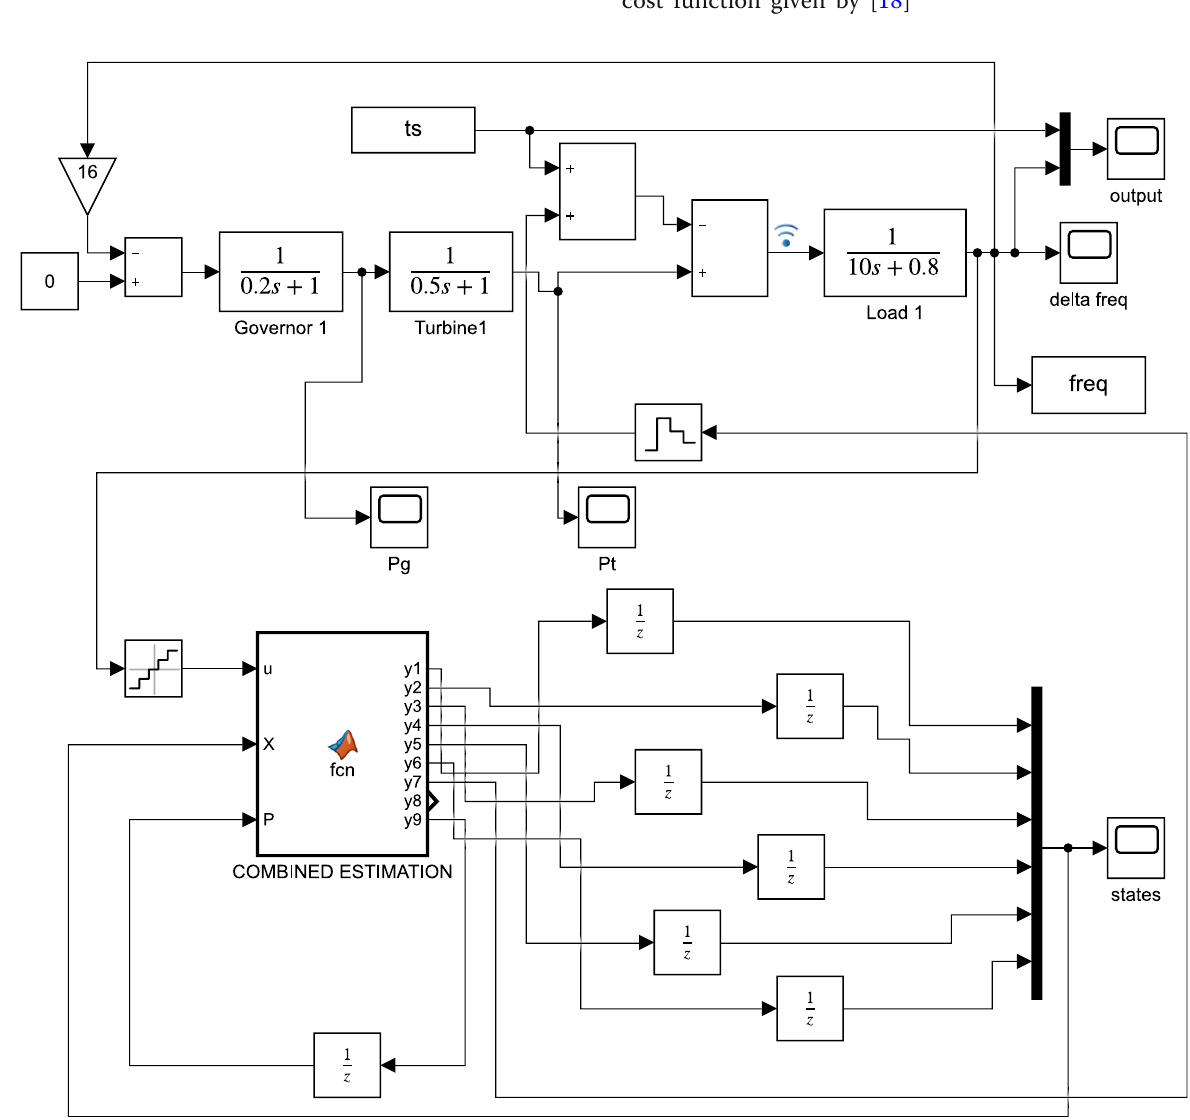
Fig. 4 Implementation of the proposed LFC in MATLAB /